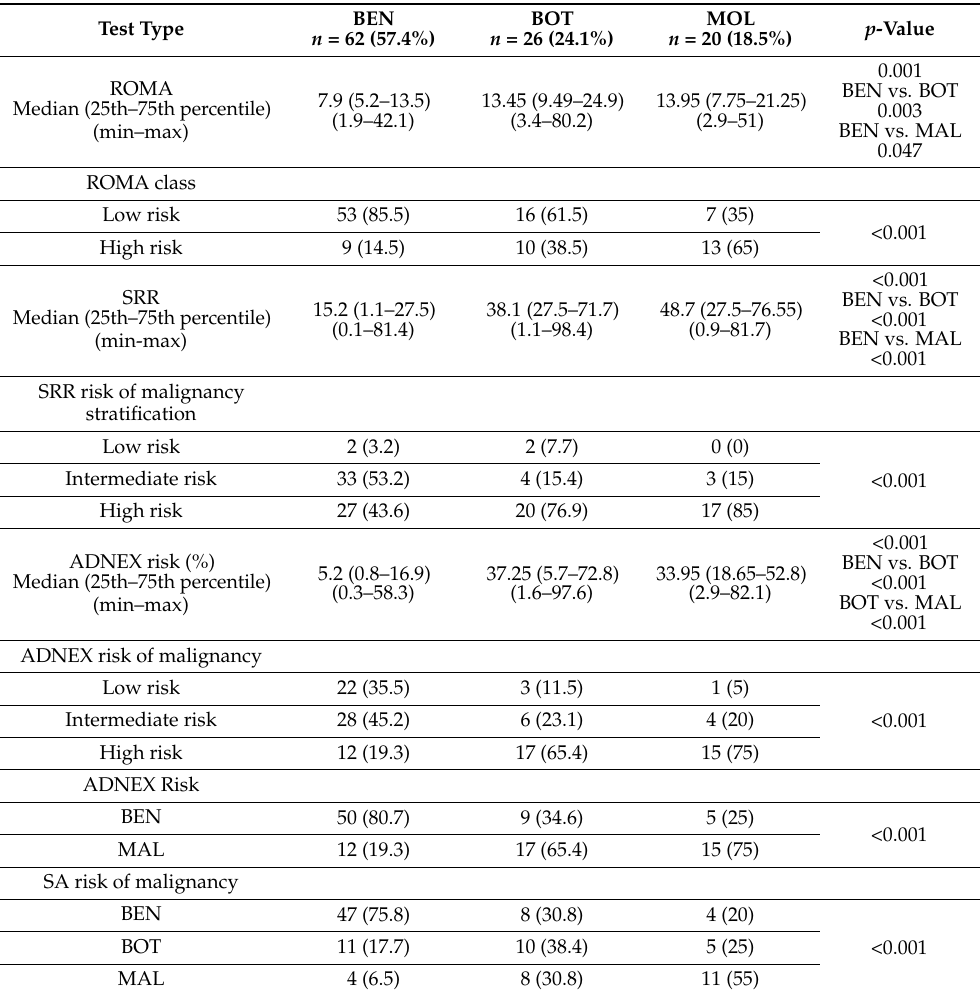
Performance of the ROMA, SA, SRR and ADNEX prognostic algorithms in the studied